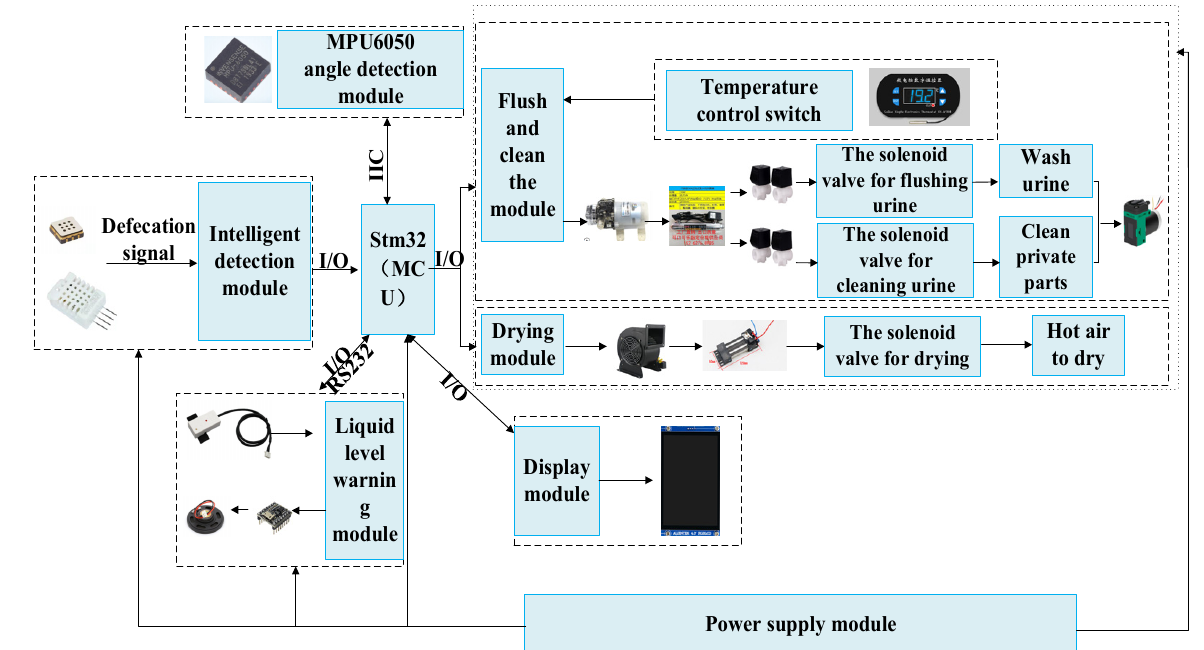
Figure 7. Control system structure diagram of excretion nursing equipment.